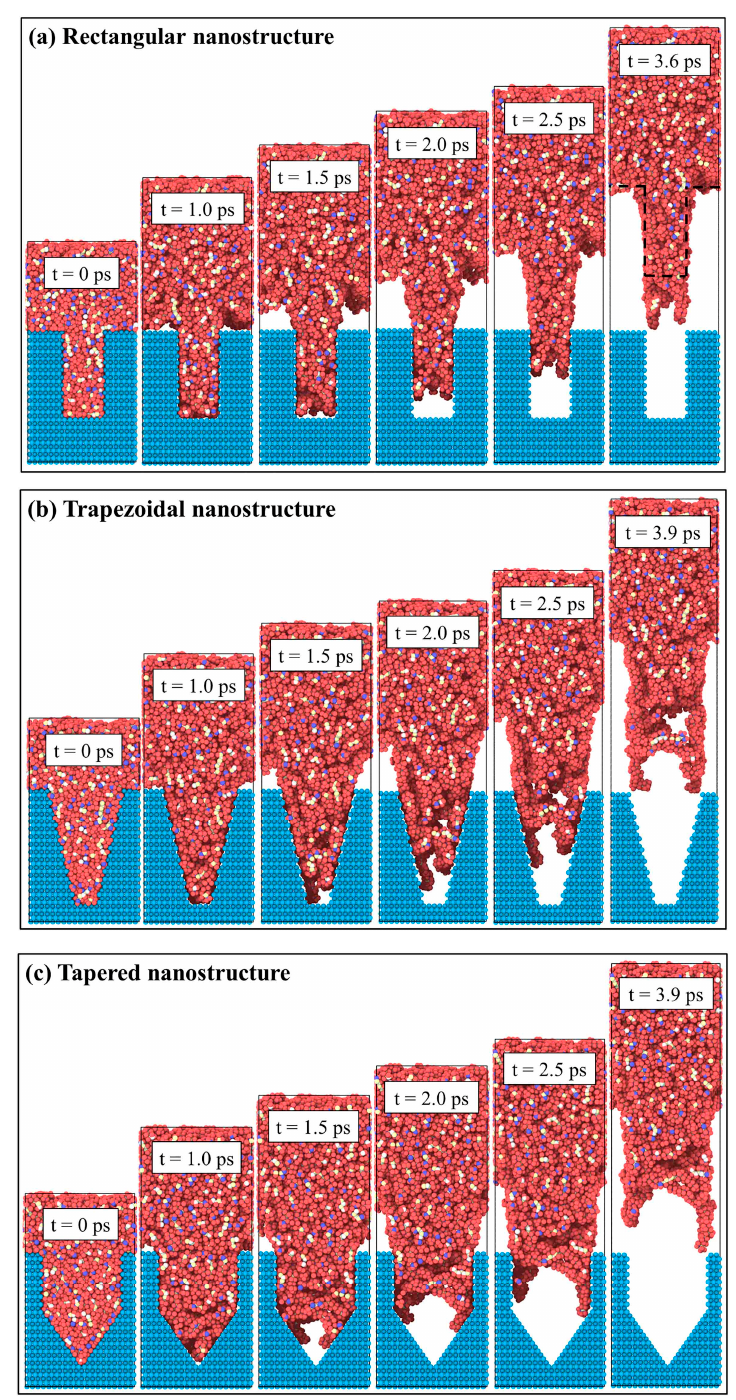
Figure 2. Snapshots of demolding processes for different polymer nanostructures: ( a ) Rectangular nanostructure, ( b ) trapezoidal nanostructure, ( c ) tapered nanostructure.